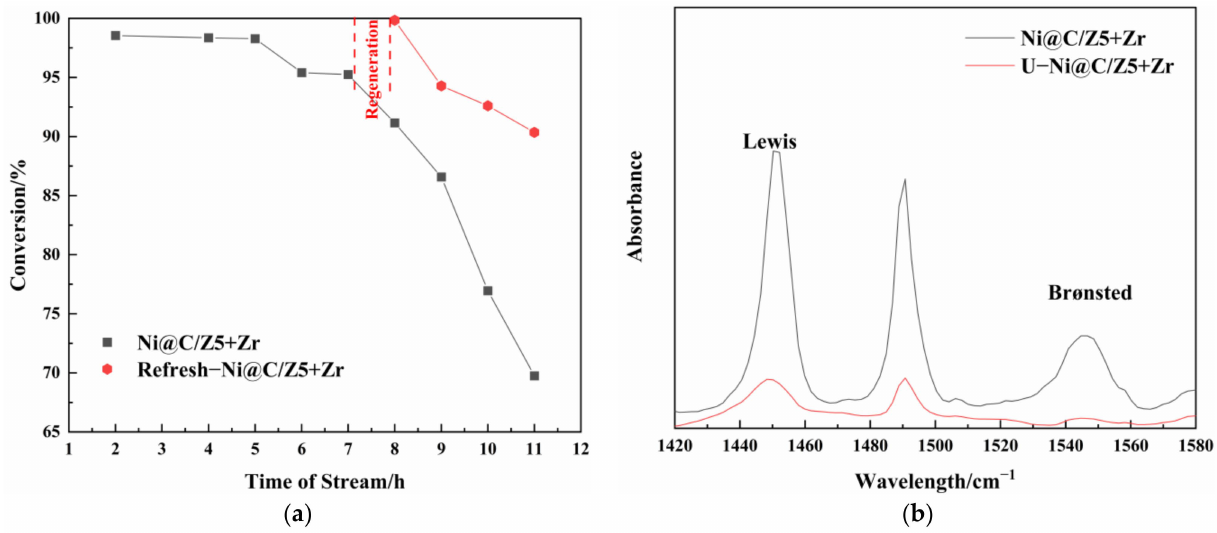
Figure 8. The lipid hydrogenation activity of refreshed catalysts ( a ) and pyridine FTIR of the catalysts at the desorption temperature of 150 ◦ C ( b